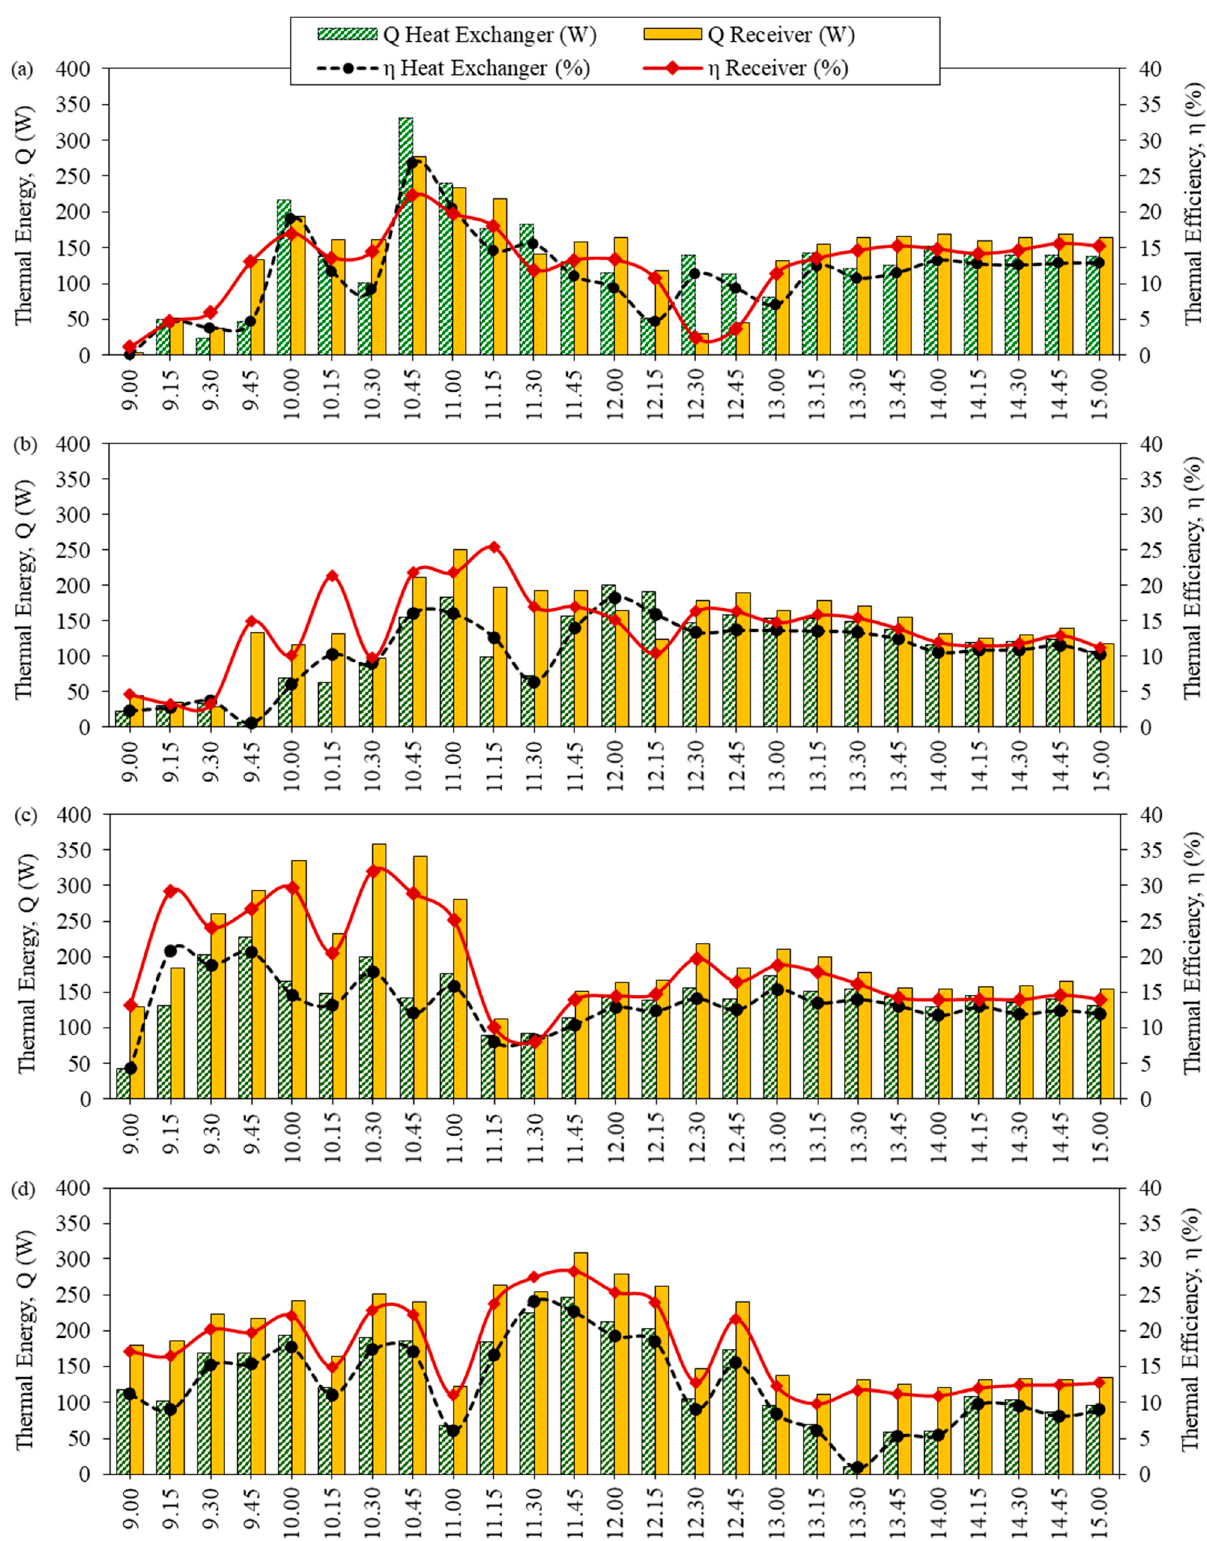
Figure 4. The efficiency of the solar collector related to thermal energy at different solution concen- trations: ( a ) 10% initial ethanol concentration, ( b ) 15% initial ethanol concentration, ( c ) 20% initial ethanol concentration, and ( d ) 23% initial Sato concentration .